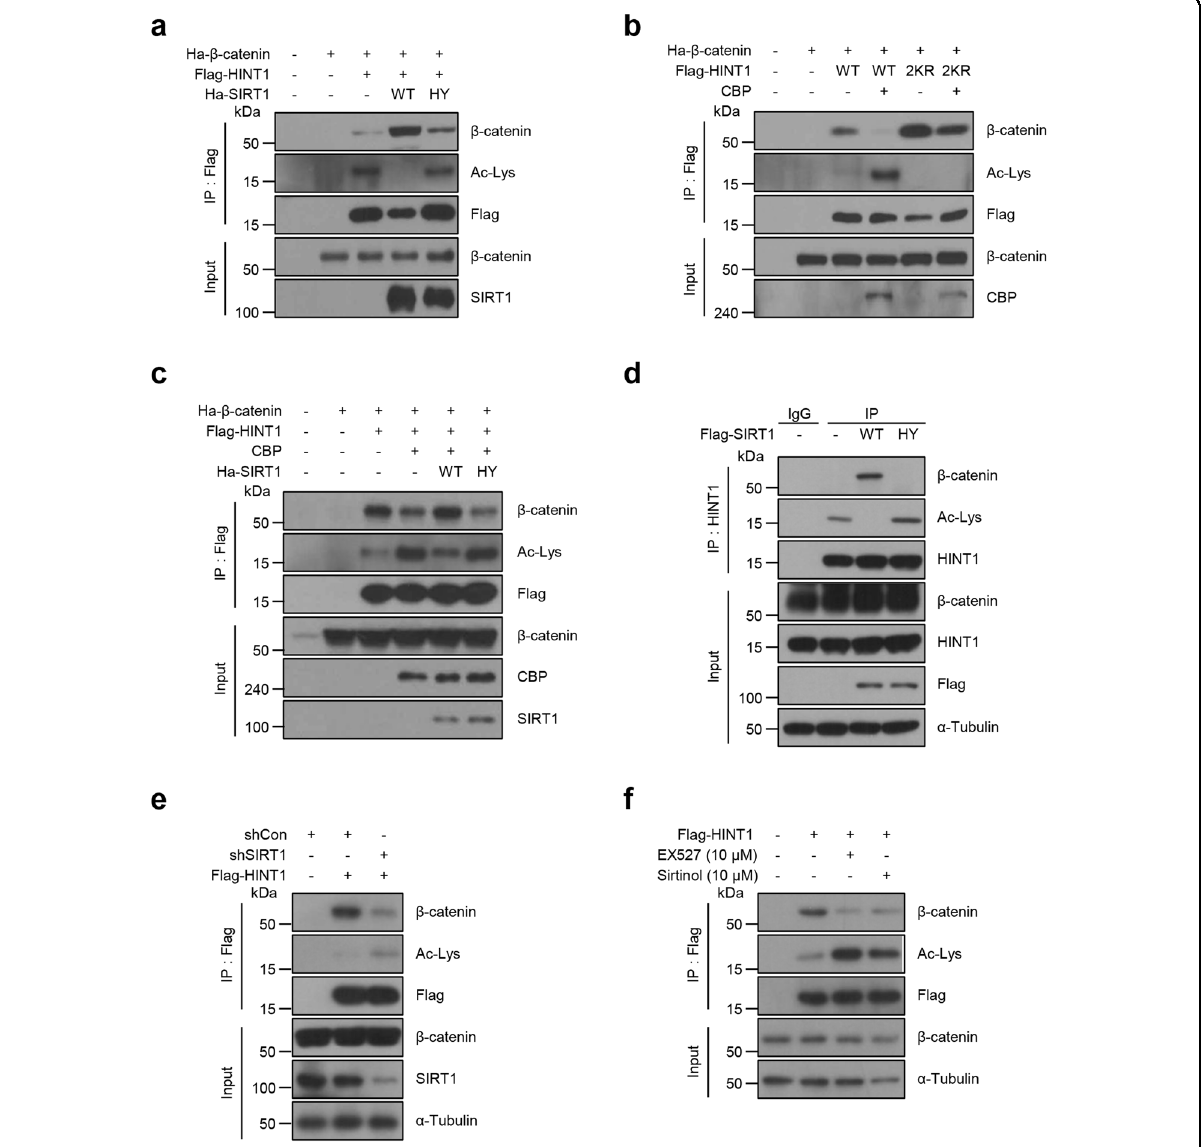
Fig. 4 Reversible acetylation of HINT1 by CBP and SIRT1 regulates the binding capacity of HINT1 for β -catenin. a – c HEK293T cells were cotransfected with several expression vectors and then subjected to IP and western blot assays using antibodies as indicated. a Coexpression of HA- β -catenin, Flag-HINT1, and HA-SIRT1 WT or HY. b Coexpression of HA- β -catenin, CBP, and Flag-HINT1 WT or 2KR. c Coexpression of HA- β -catenin, Flag-HINT1, CBP, and HA-SIRT1 WT or HY. d Flag-SIRT1 WT or HY was expressed in DLD1 cells, and IP and western blot assays were performed using antibodies as indicated. e DLD1 cells in which SIRT1 was knocked down by a lentiviral system (shSIRT1) were transfected with Flag-HINT1. f DLD1 cells were transiently transfected with Flag-HINT1 and treated with EX527 (10 µM) and sirtinol (10 µM) for 12 h. e , f Followed by IP and western blot assays using antibodies as